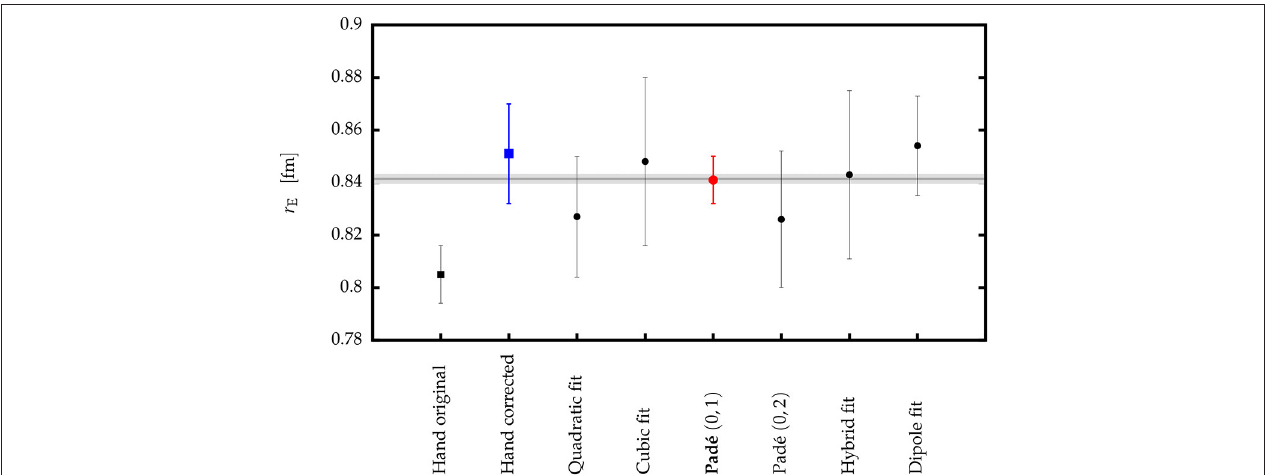
FIGURE 5 | The comparison of the extracted proton charge radii. The square points show the value calculated with the classical approach described in section 2 and the original result of Hand et al. [2]. The circles represent the model-dependent extractions of the radius obtained with the new analysis technique presented in section 3. The error bars show corresponding standard errors. According to the Monte-Carlo simulation the most robust estimate for the radius can be obtained using model (4), shown with the red circle. The gray band represents the new recommended value (CODATA 2018, [31]).